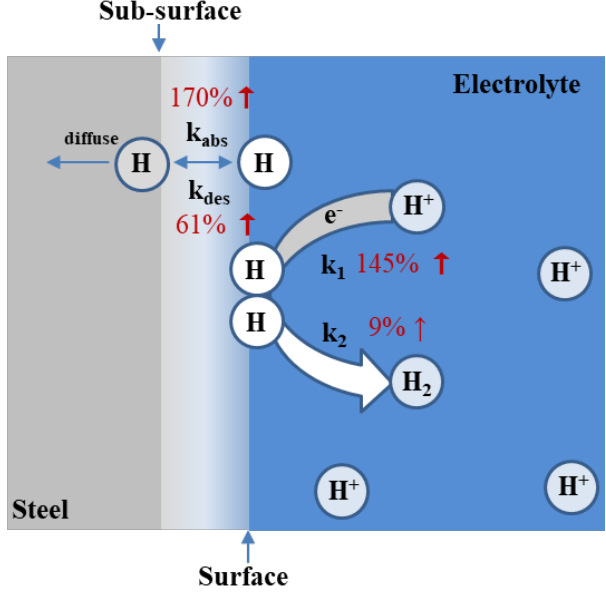
Figure 7. The schematic of Mo addition effect on HER. According to the first-principle calculation results, the adsorption energy decreased from − 0.386 eV to − 0.778 eV with the increased Mo surface doping due to the stronger bonding ability of Mo-H than Fe-H. Thus, the forward reaction of the hydrogen adsorption reaction, Reaction (1), was promoted and θ